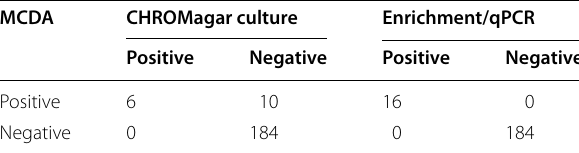
Table 3 The detection results of the MCDA assay compared to CHROMagar culture and